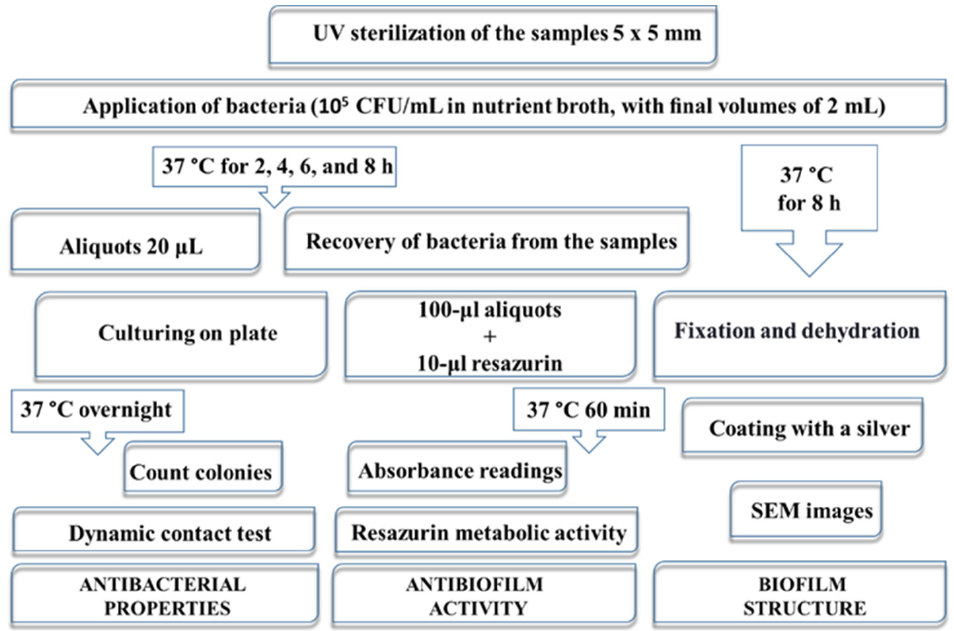
Figure 11. Schematic overview of the in vitro antibacterial